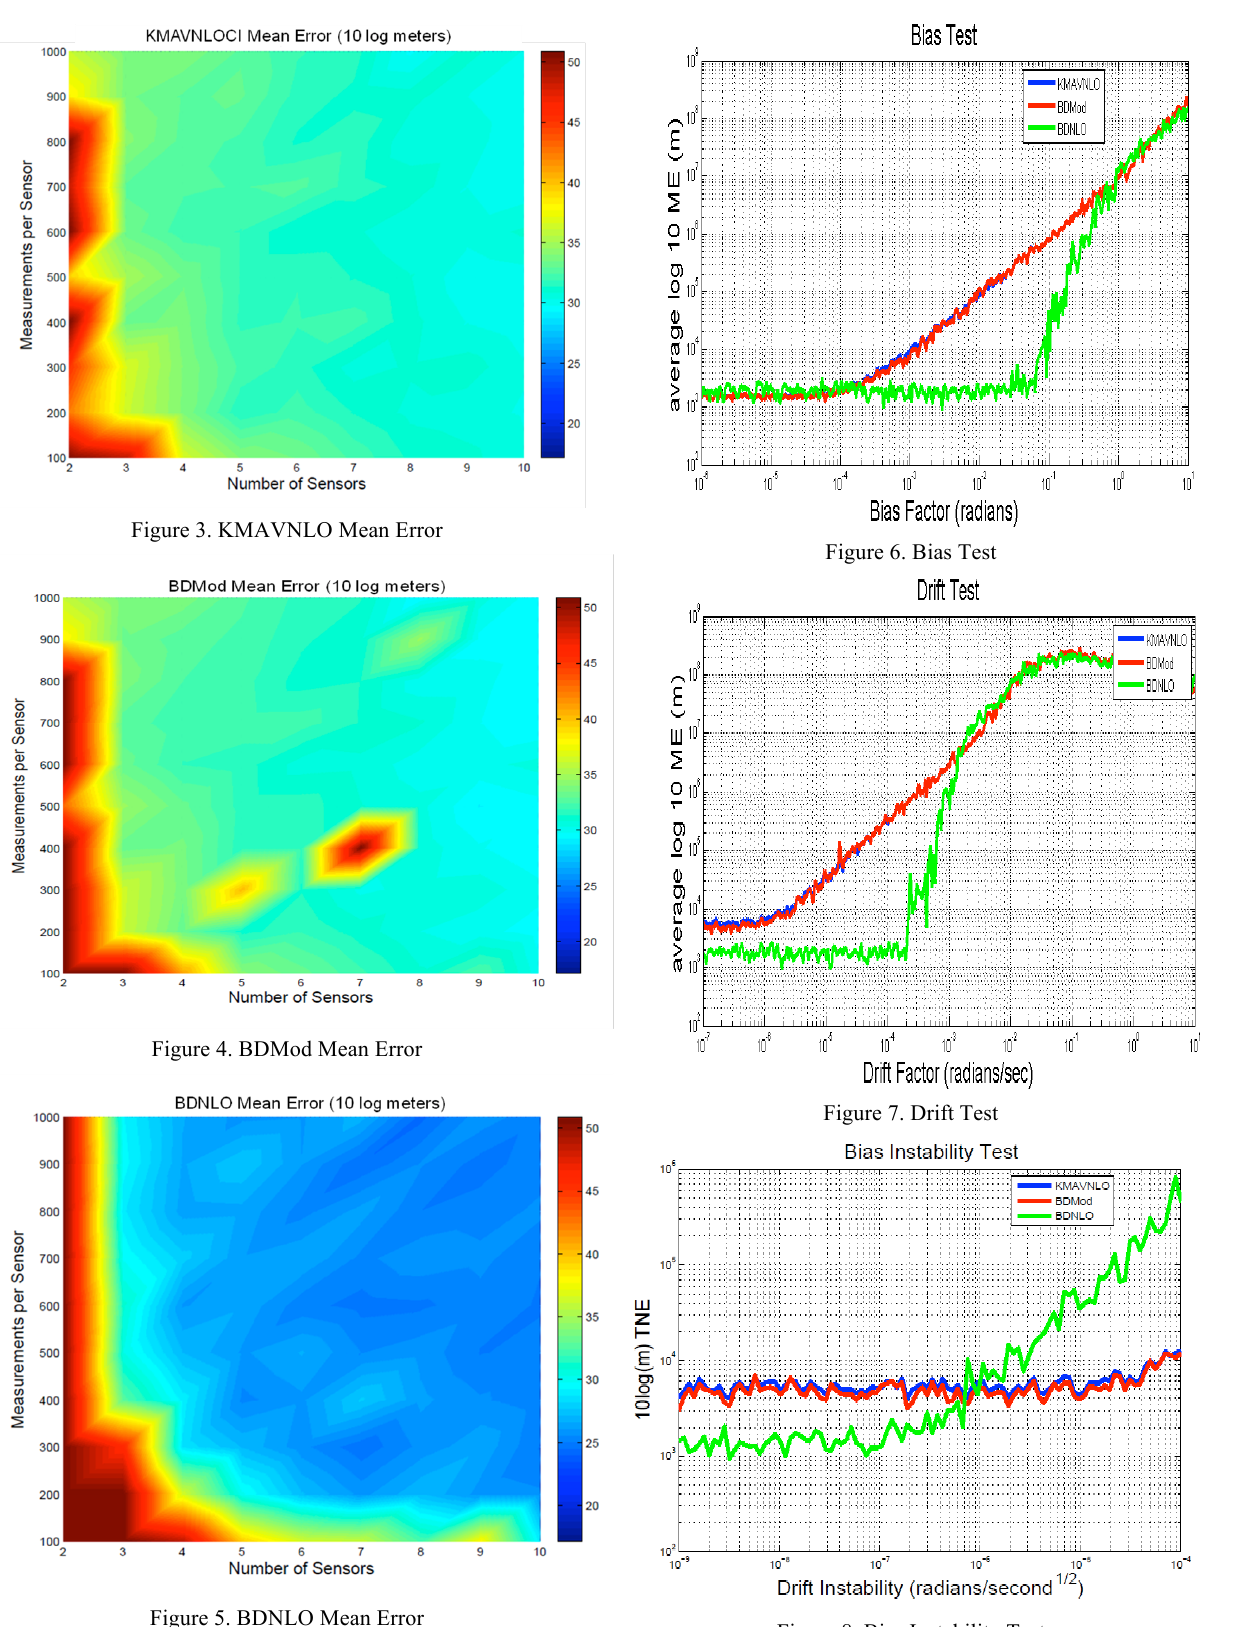
Figure 8. Bias Instability